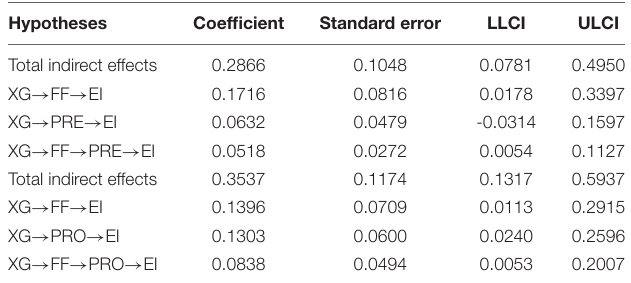
TABLE 6 | Bootstrap mediation effect test